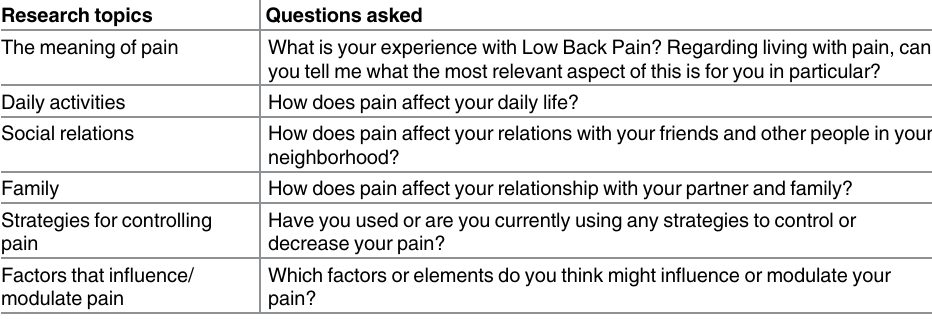
Table 2. Question guide for the semi-structured interview.